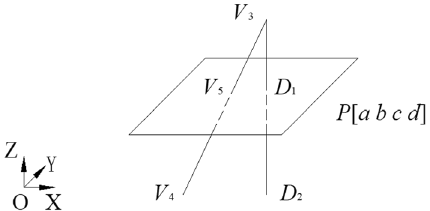
Figure 13. The intersection point between line and plane.